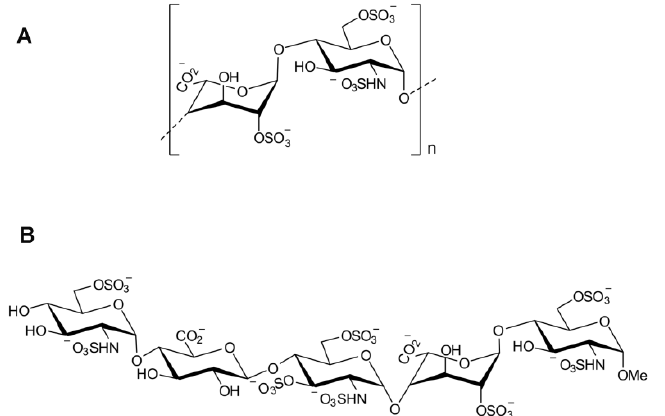
Figure 3. ( A ) The repeated sulfate disaccharides structure of heparin. ( B ) The pentasaccharide responsible for the anticoagulant activity of fondaparin.